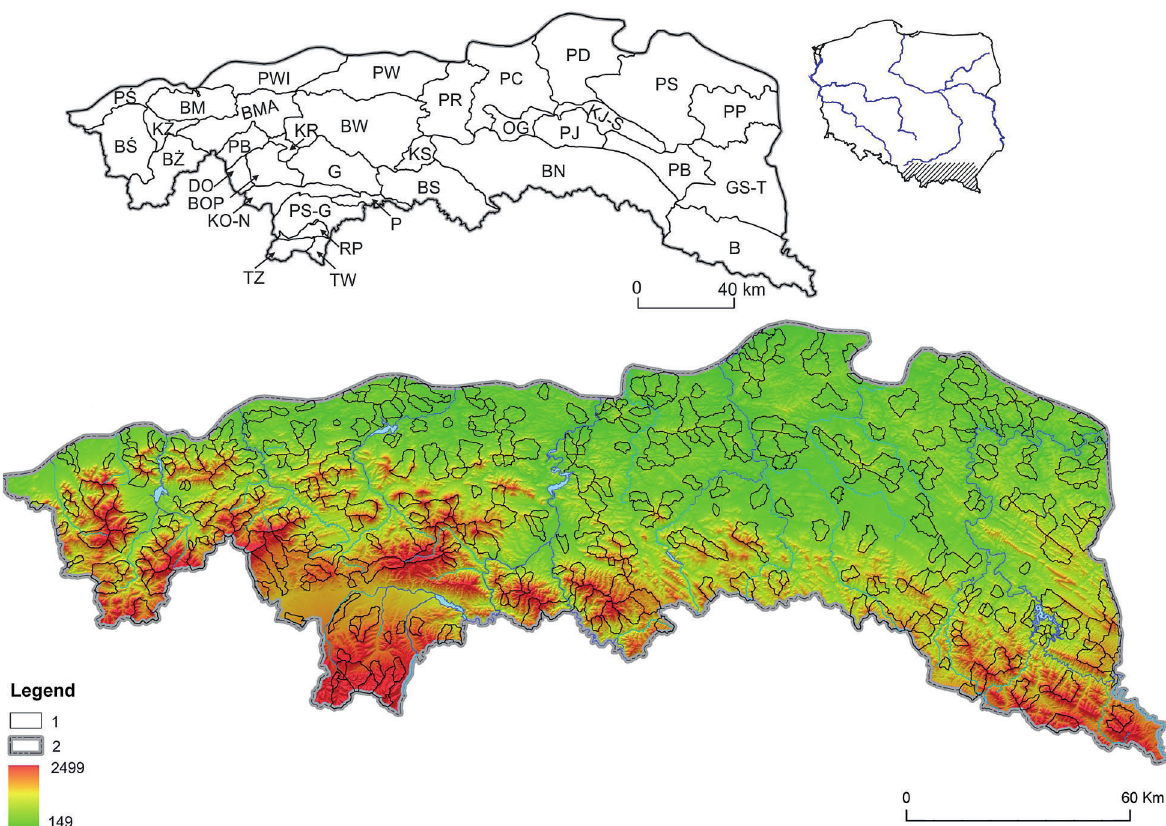
fig. 6. Distribution of catchments where the “Horton’s and Schumm’s laws” were fulfilled. 1 – catchments, 2 – the study area Geographical regions after J. Kondracki (1994). PŚ – Śląskie foothills, PWI – Wielickie foothills, PW – Wiśnickie foothills, PR – Rożnowskie foothills, PC – Ciężkowickie foothills, PD – Dynowskie foothills, PS – Strzyżowskie foothills, PP – Przemyskie foothills, PB – Bukowskie foothills, PJ – Jasielskie foothills, PS-G – Spisko-Gubałowskie foothills, BŚ – Beskid Śląski, Bm – Beskid mały, BŻ – Beskid Żywiecki, PB – the Babia Góra Ridge, DO – Działy Orawskie, BOP – Beskid Orawsko-Podhalański, BmA – Beskid makowski, BW – Beskid Wyspowy, BS – Beskid Sądecki, BN – Beskid Niski, B – Bieszczady mts. KS – Sądecka Basin, KR – Rabczańska Basin, KŻ – Żywiecka Basin, KO-N – Orawsko-Nowotarska Basin, DJ-S – Jasielsko-Sanocka Basin, OG – Gorlice Basis, RT – Podtatrzański Trench, TW – the eastern Tatra mts., Tz – the Western Tatra mts. P – the Pieniny mts., GTS – the Sanocko-Turczańskie